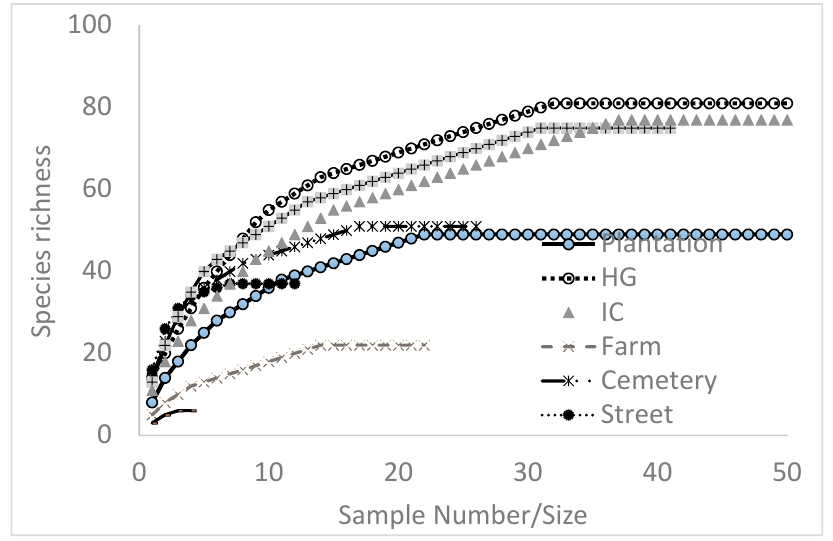
Figure 2. Rarefaction curves of woody species among green spaces in Kumasi. IC = Institutional compound, HG = home garden. Table 1. Tree species abundance, richness, and diversity indices in different green space types within Kumasi. Chi-square analysis of richness indicates significant differences ( p < 0.0001, n = 8, X 2 =